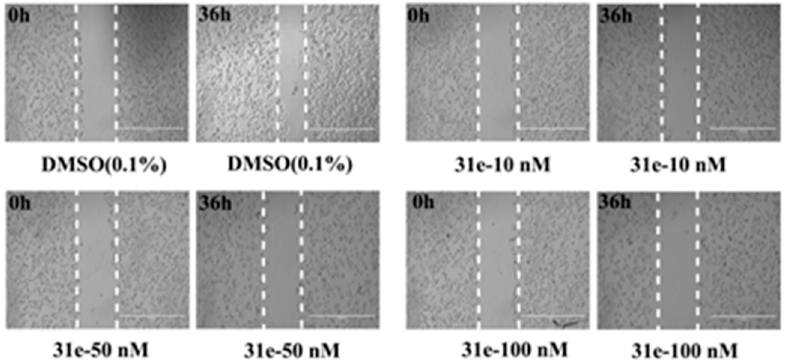
Figure 5. Compound 31e inhibits c-Met phosphorylation and downstream signaling in cancer cell lines. Cells treated with compound 31e for 1 h or 2 h were then lysed and subjected to Western blot analysis.